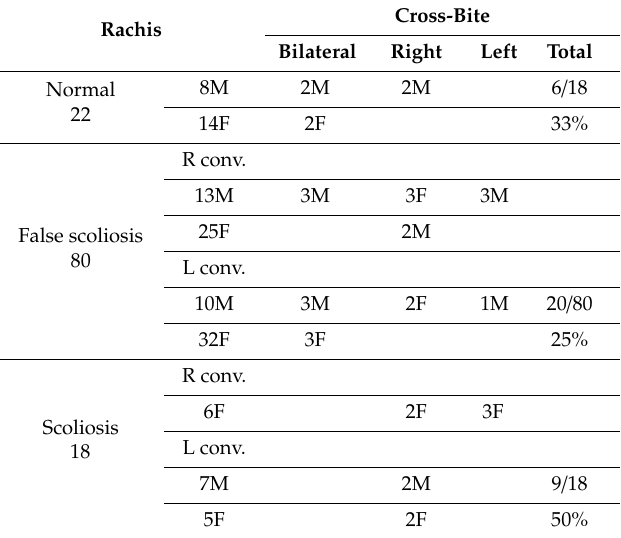
Table 1. Relations between scoliosis and cross-bite in our sample.